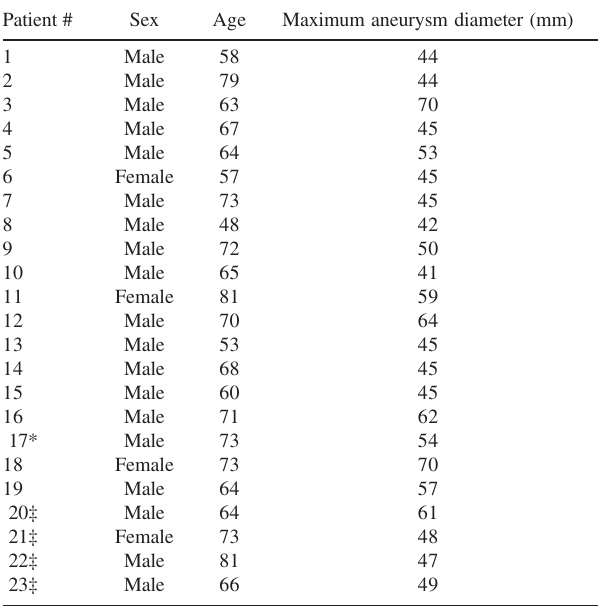
Table 1 - Patient demographics in this study.